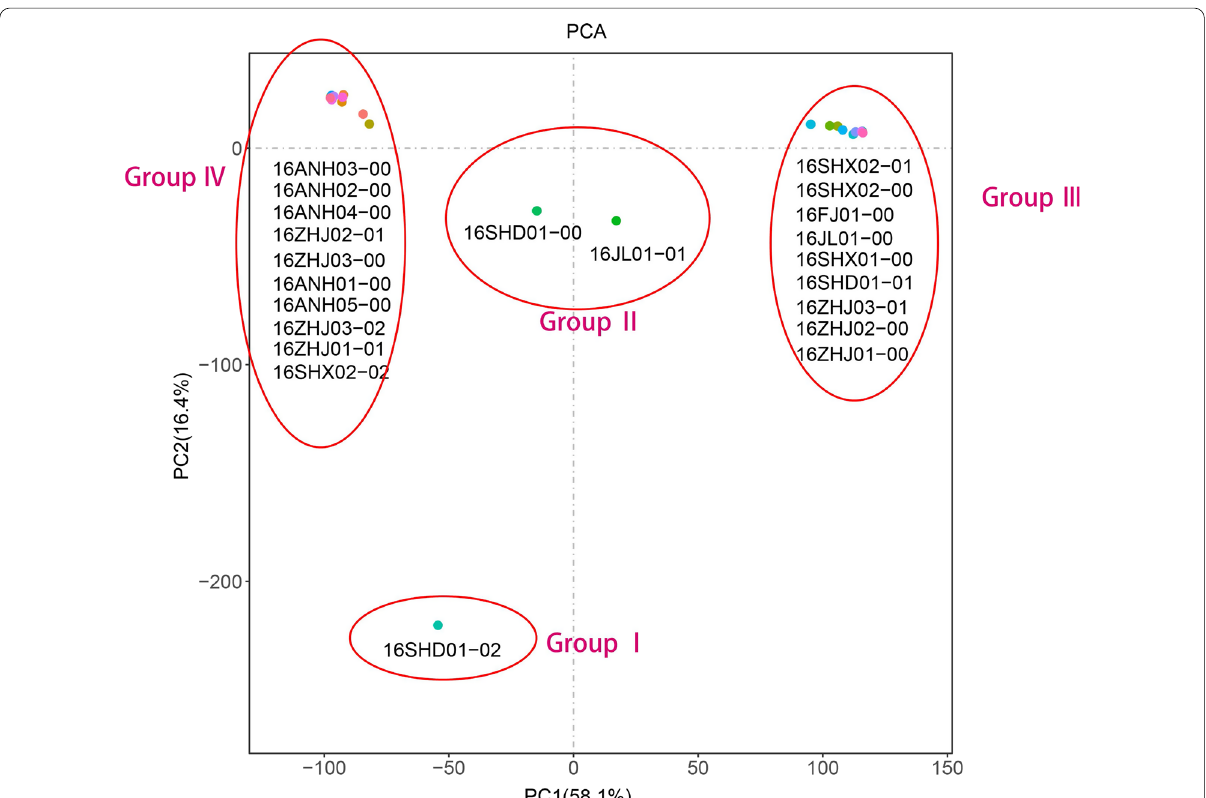
Fig. 2 Principal component analysis of 22 lingzhi strains based on